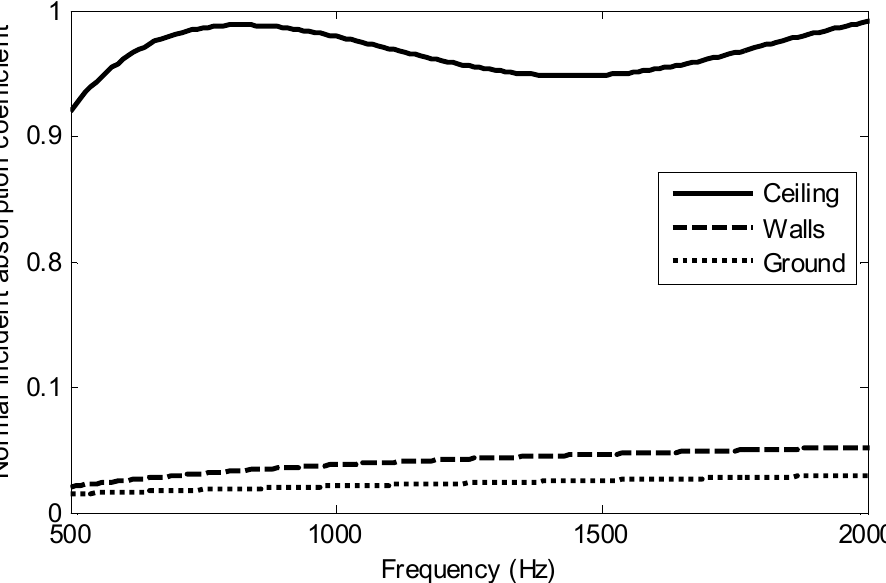
Figure 2. Spectra of the normal incident absorption coefficient on four boundaries of the rectangular long space in numerical simulations.